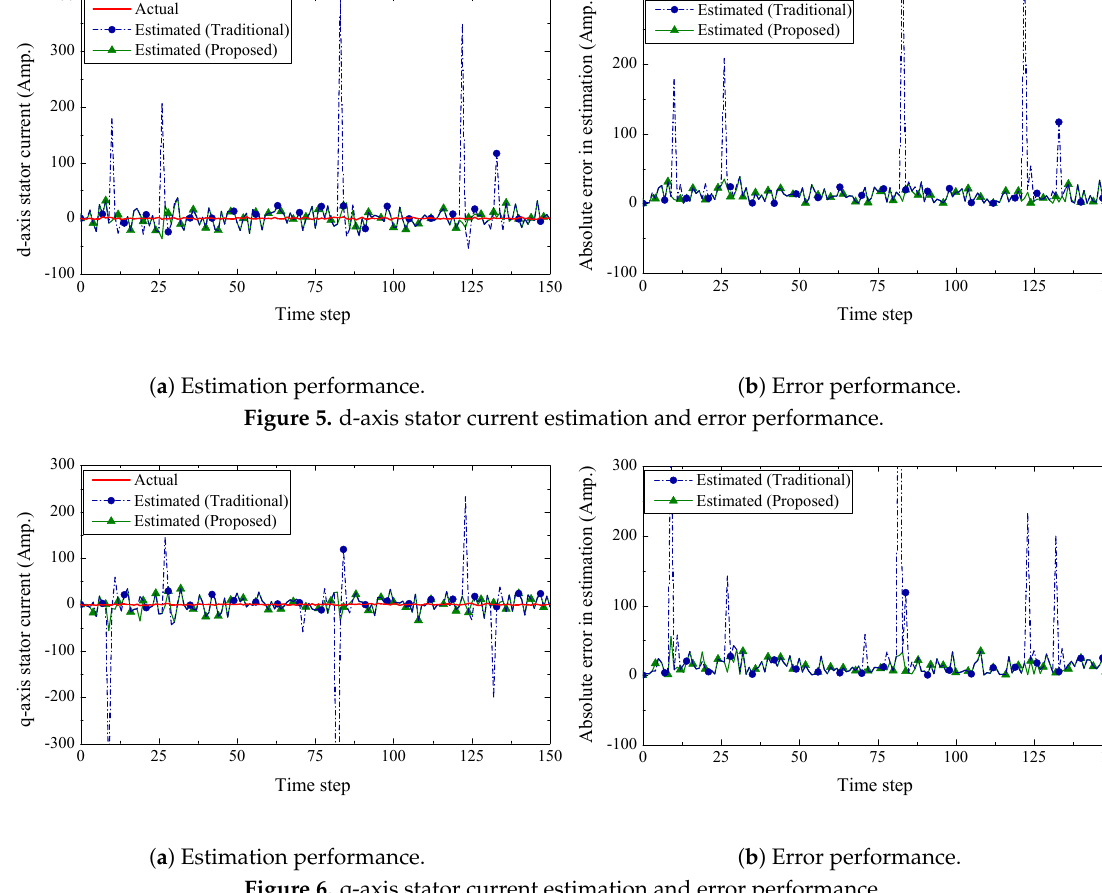
Figure 6. q-axis stator current estimation and error